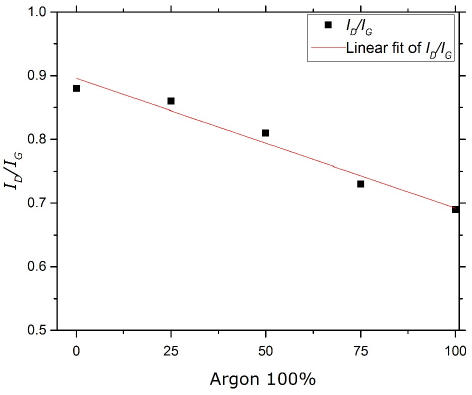
Figure 13. I D / I G packs vs. argon percentage.